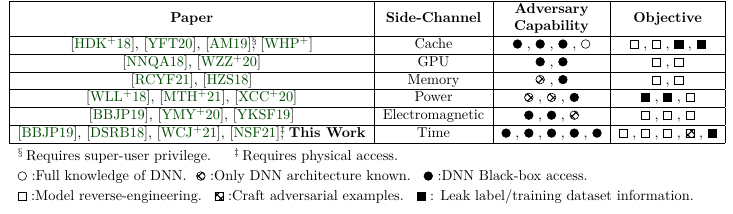
Table 1: Summary of our contribution compared to related works using side-channels on